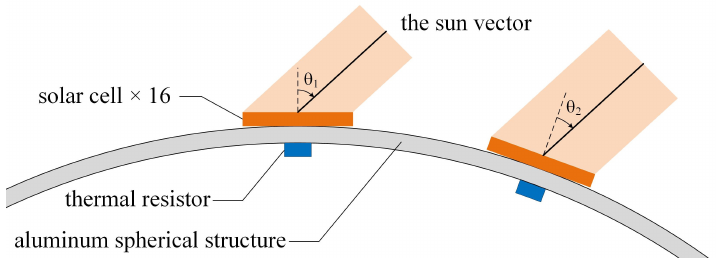
Figure 2. The IPSS consists of 16 evenly distributed solar cells, 16 thermistors underneath each solar cell, and corresponding sampling